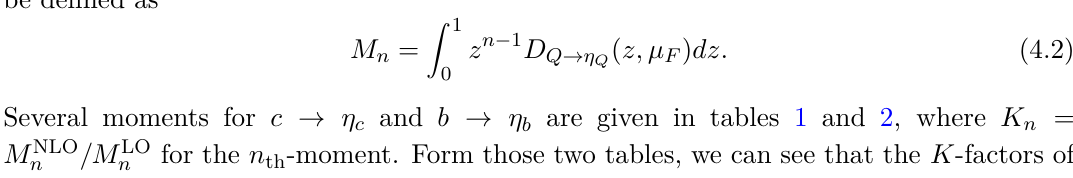
Figure 5 . The fragmentation function D c → η where µ F = 3 m c and µ R = 2 m c . The bands are obtained by varying the factorization scale µ F by a factor of